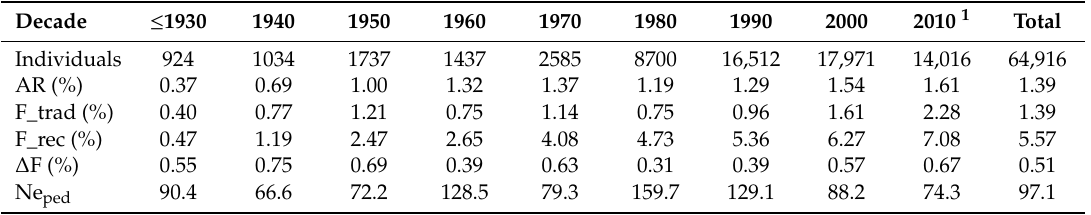
Table 3. Average relatedness (AR), traditional (F_trad) and recursive (F_rec) inbreeding, individual increase in inbreeding ( ∆ F), and e ff ective population size (Ne ped ) from pedigree data for each decade of birth and for the total Italian Heavy Draught Breed